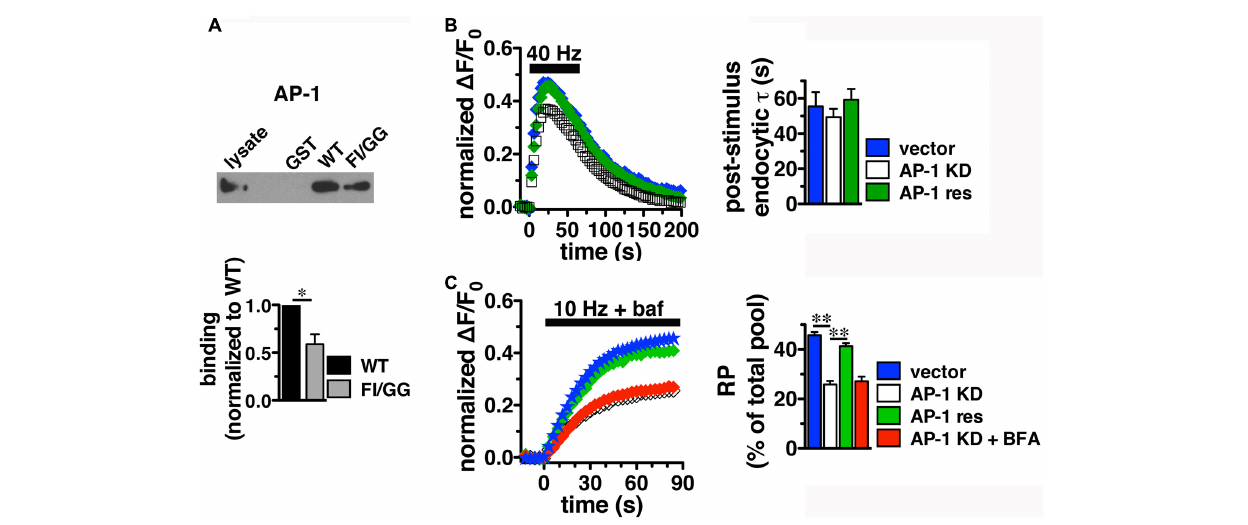
FIGURE 7 | Adaptor protein AP-1 interacts with VGLUT2 and affects the amount of VGLUT2-pH in the RP . (A) A GST fusion of the WT VGLUT2-pH C-terminus pulls down AP-1 from rat brain lysate, but the F 518 I 519 mutation disrupts the interaction. Bound proteins were detected by immunoblotting with AP-1 antibody (anti-adaptin γ ). Top panel shows a representative immunoblot, bottom shows the quantification of band intensity from at least three independent experiments, ∗ p < 0.05. (B) Left panel: Time course of fluorescence changes in boutons from neurons expressing VGLUT2-pH infected with viral particles expressing either vector control (blue) or AP-1 γ (open squares), or co-expressing an siRNA resistant 1 γ (green). Quantification of peak fluorescence level as a fraction of total pool confirms a reduction with AP-1 KD (white, 37.69 ± 1.60%) compared to vector control (47.63 ± 1.03%, ∗∗ p < 0.01). Co-expression of a construct carrying an siRNA resistant 1 γ rescues the peak reduction (green, 46.45 ± 2.48%, n = 7). Right panel: Neither the post-stimulus endocytic τ decay (right panel, vector, 55.50 ± 8.08 s vs. KD, 49.45 ± 4.69 s) nor fluorescence decay during stimulation [ (cid:49) ( (cid:49) F/F 0 ): vector, 27.45 ± 3.46% vs. AP-1 KD, 32.81 ± 1.65%] is significantly affected by AP-1 depletion. Data in (B,C) are means ± SEM of (cid:49) F/F 0 , acquired every 3 s, normalized to total fluorescence. Data are from at least 33 boutons per coverslip from 5 to 7 coverslips from at least two independent cultures. (C) Depletion of AP-1 decreases the amount of VGLUT2-pH in the RP, released by 900 action potentials at 10 Hz in the presence of bafilomycin (vector, 45.75 ± 1.34% of total pool, n = 22; AP-1 KD, 25.86 ± 1.40%, n = 18, ∗∗ p < 0.01). Co-expression of an siRNA resistant 1 γ rescues this reduction (41.33 ± 1.24%, n = 11, ∗∗ p < 0.01). BFA treatment has no additional effect on AP-1 KD (red, 27.14 ± 1.85%, n = 8). The rate of exocytosis in response to 10 Hz 90 s stimulation is not significantly altered by either AP-1 knockdown, rescue, or inhibition by BFA [ (cid:49) F/F 0 (au/s): vector 0.0275 ± 0.0007; AP-1 KD 0.0269 ± 0.0013; AP-1 KD + res 0.0267 ± 0.0021; AP-1 KD + BFA 0.0254 ± 0.0023]. Data in (C) are from at least 28 boutons per coverslip from 8 to 22 coverslips from at 4–6 independent